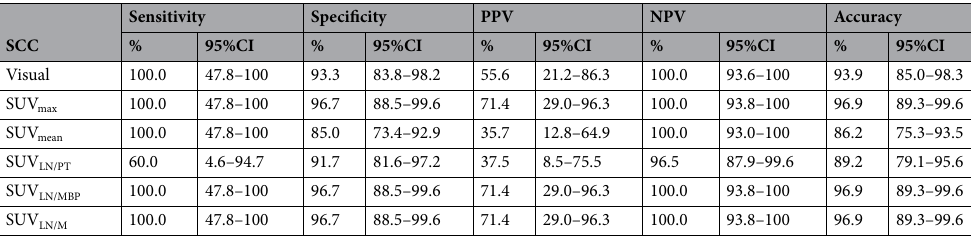
Table 5. Diagnostic performances of the SUV parameters at 18 F-Alfatide PET/CT in patients with SCC. SCC, squamous cell carcinoma; SUV, standardized uptake value; LN, lymph node; MBPS, mediastinal blood pool; M, muscle; PPV, positive predictive value; NPV, negative predictive value; CI, confidence